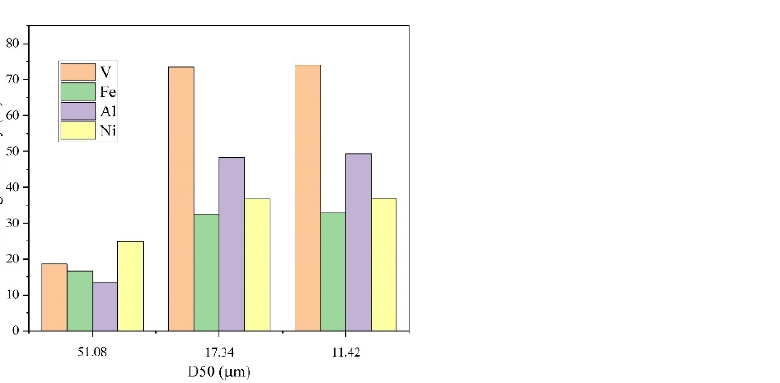
Figure 4. Effects of particle size on leaching efficiency of metals (C C2H2O4 = 2 mol/L; T = 95 °C; t = 240 min).